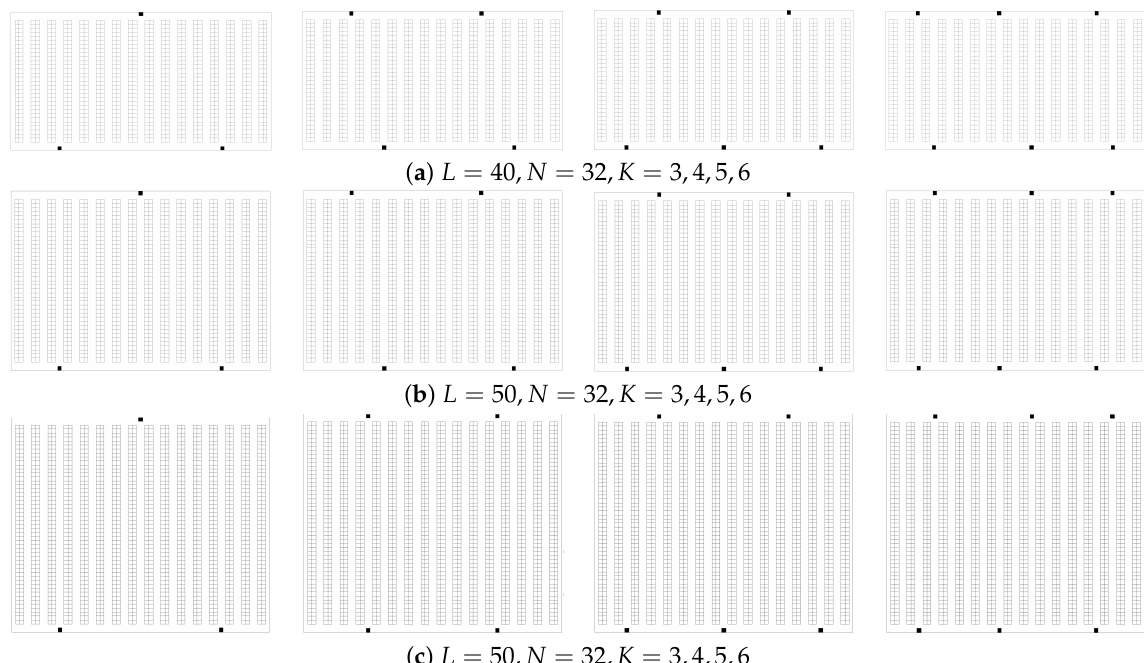
Figure 7. Optimal workstation layout under traditional